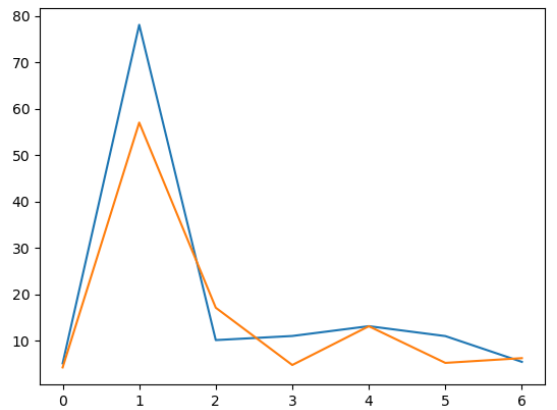
Figure 8. Results in the target database using proposed model. Random search comparative